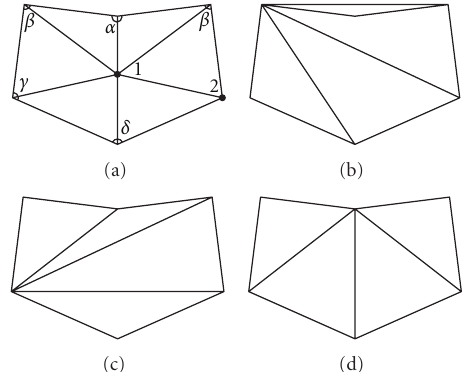
Figure 2: Graphical representation of factor F and f values used to limit segment marking. Figure 3: Segment collapsing with shell control: (a) initial shell, (b) shell inversion collapse, (c) collapse with element distortion, and (d) best collapse